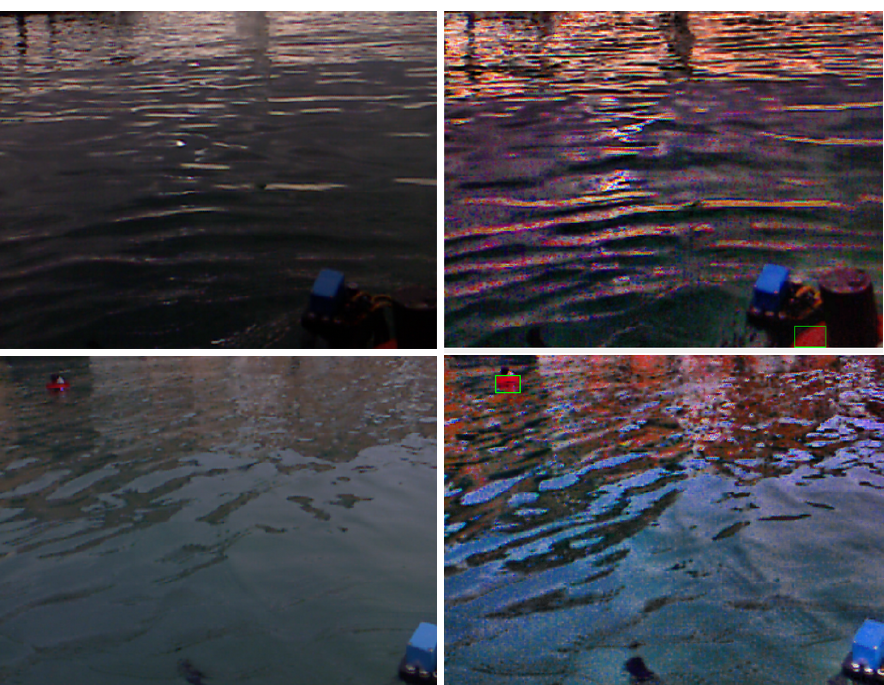
Figure 13. Two examples of aMussel top cap detection, original images captured from the Kinect camera RGB stream ( left ) and processed images ( right ). Detected aMussel bounding boxes shown in green.